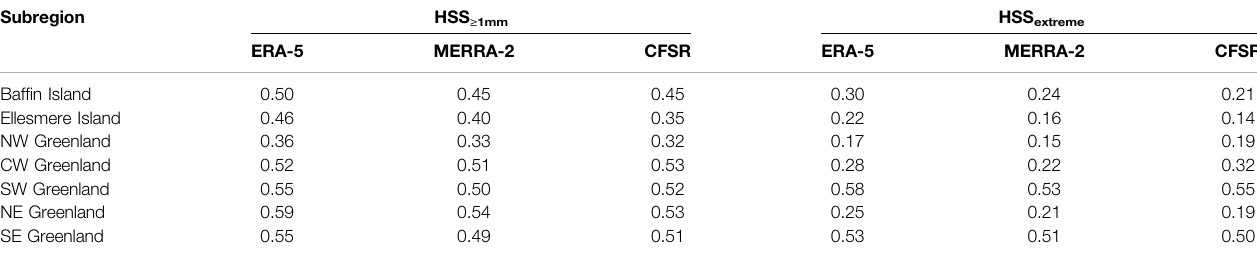
TABLE 5 | HSS for the reanalyses in each subregion. HSS ≥ 1mm refers to that of all precipitation days with at least 1 mm of accumulation ( Eq. 2 ), and HSS extreme refers to extreme events using ( Eq. 3